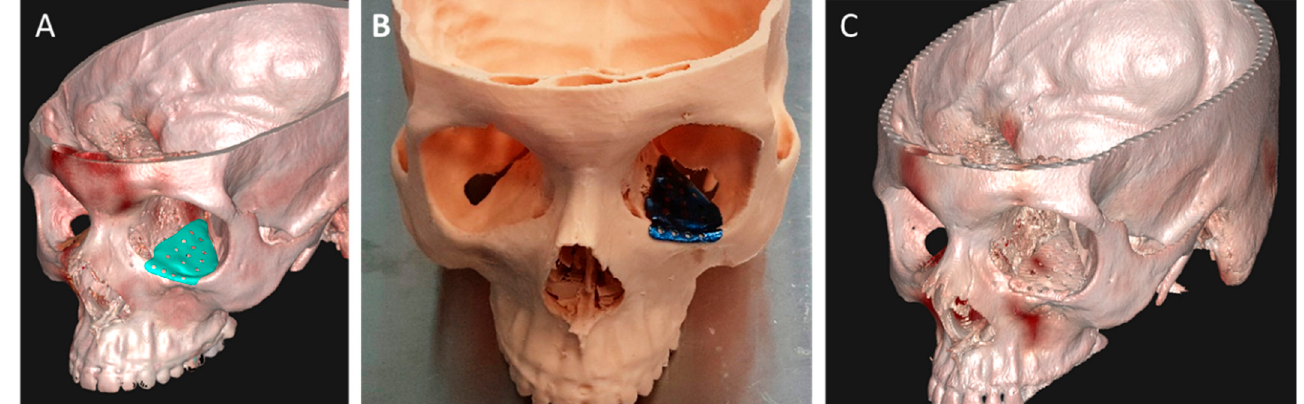
Figure 6. PSI design and 3D printing used for orbital floor reconstruction. VSP-based mirroring is utilized to design PSI for orbital floor reconstruction ( A ). Designed titanium implant fabricated via SLS 3D printing ( B ). Post-operative 3D imaging depicts accuracy of implant adaptation to the damaged anatomy ( C ).